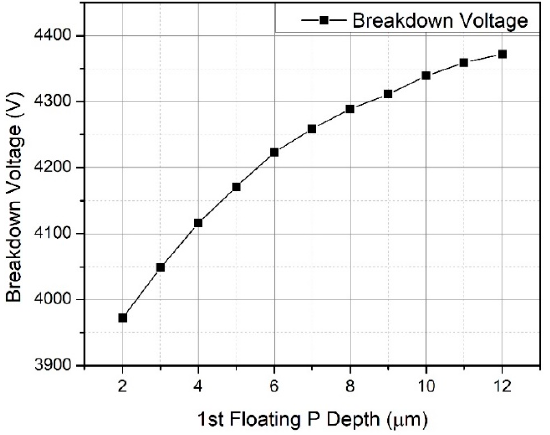
Figure 2. Relationship of different floating P-type structure depths and breakdown voltage.